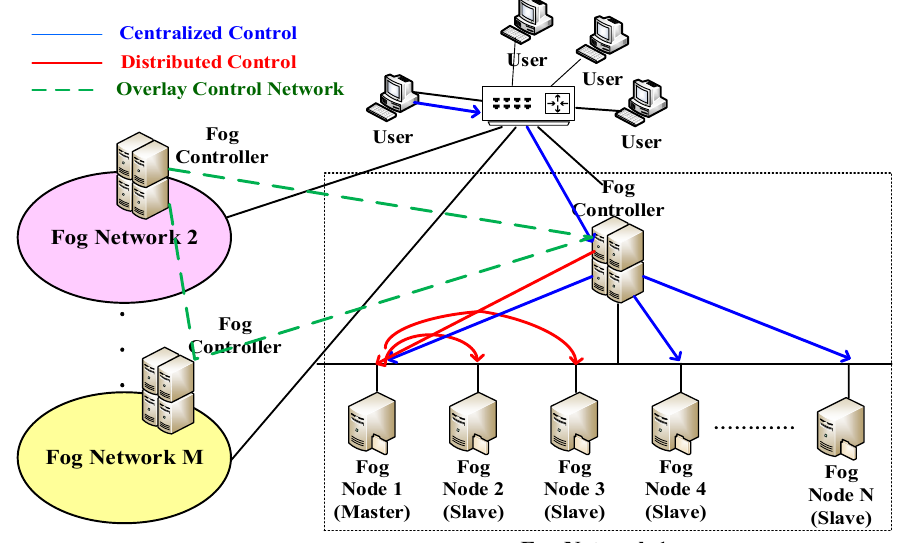
Figure 1. System architecture of fog networks.